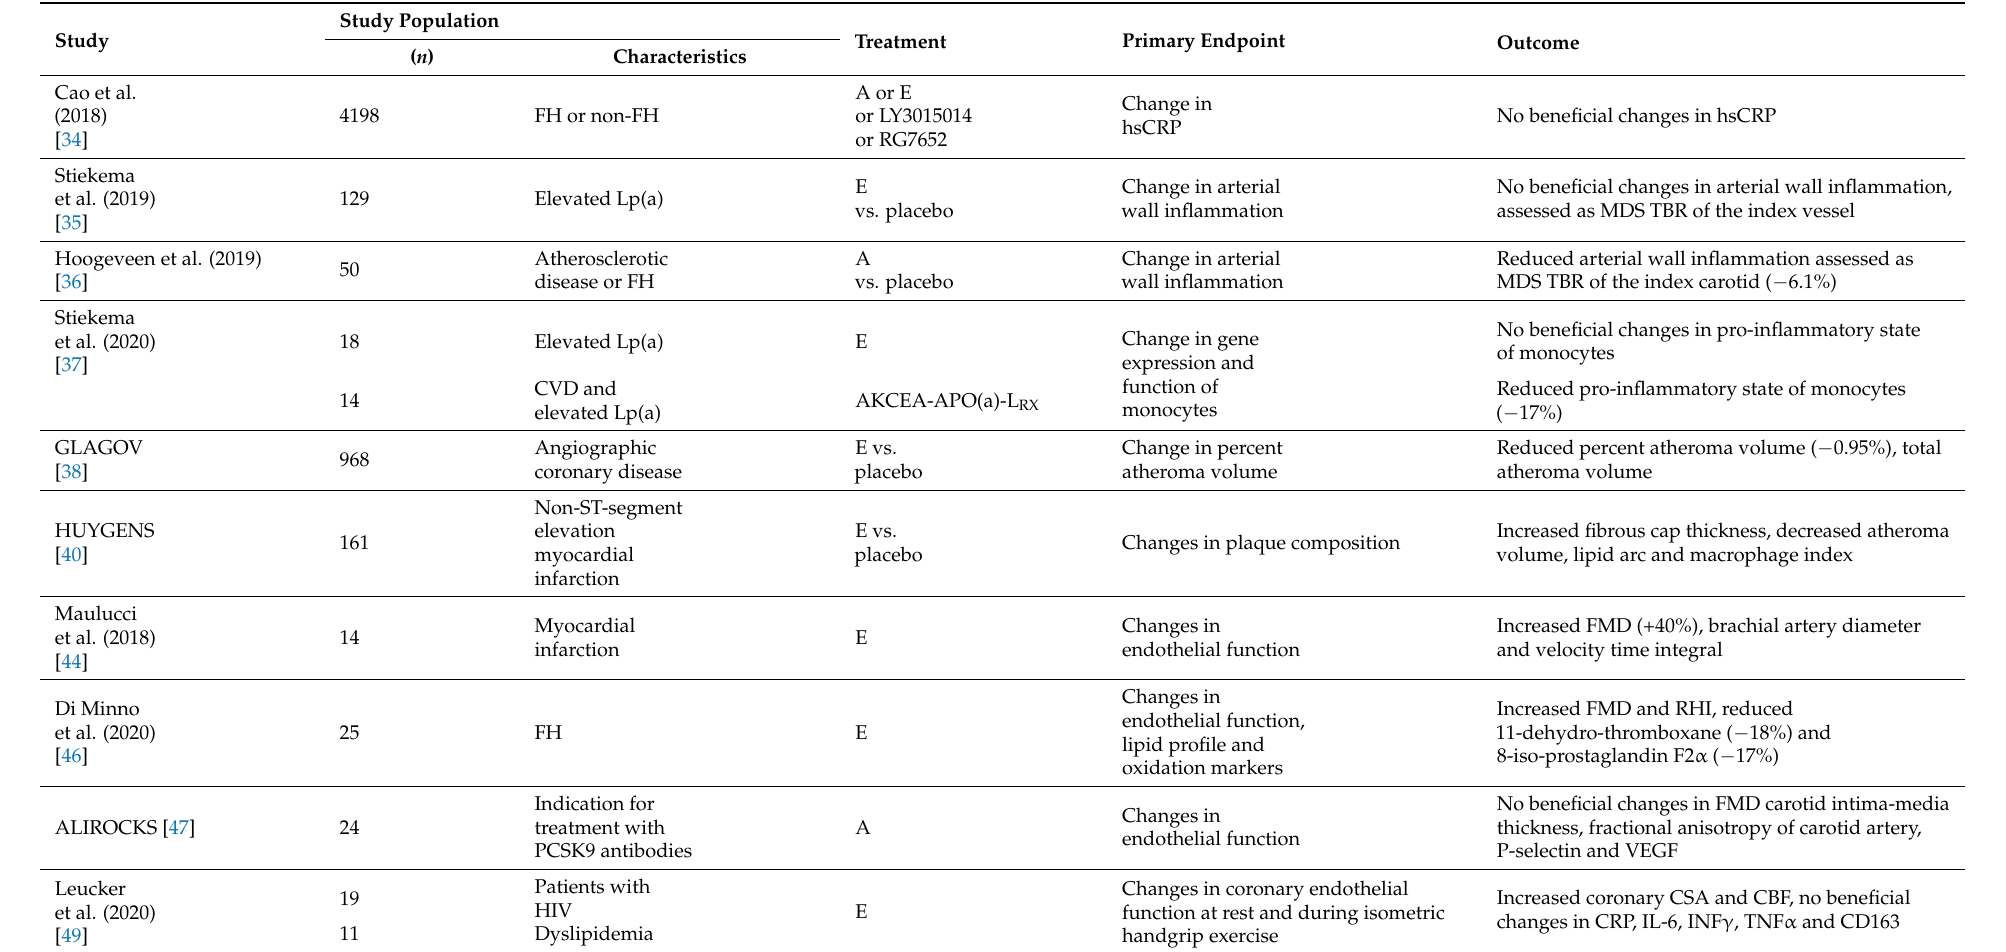
Table 1. Overview of the studies that have evaluated the effects of PCSK9 monoclonal antibodies on inflammation, endothelial function and haemostasis. For full trial names and details, see main